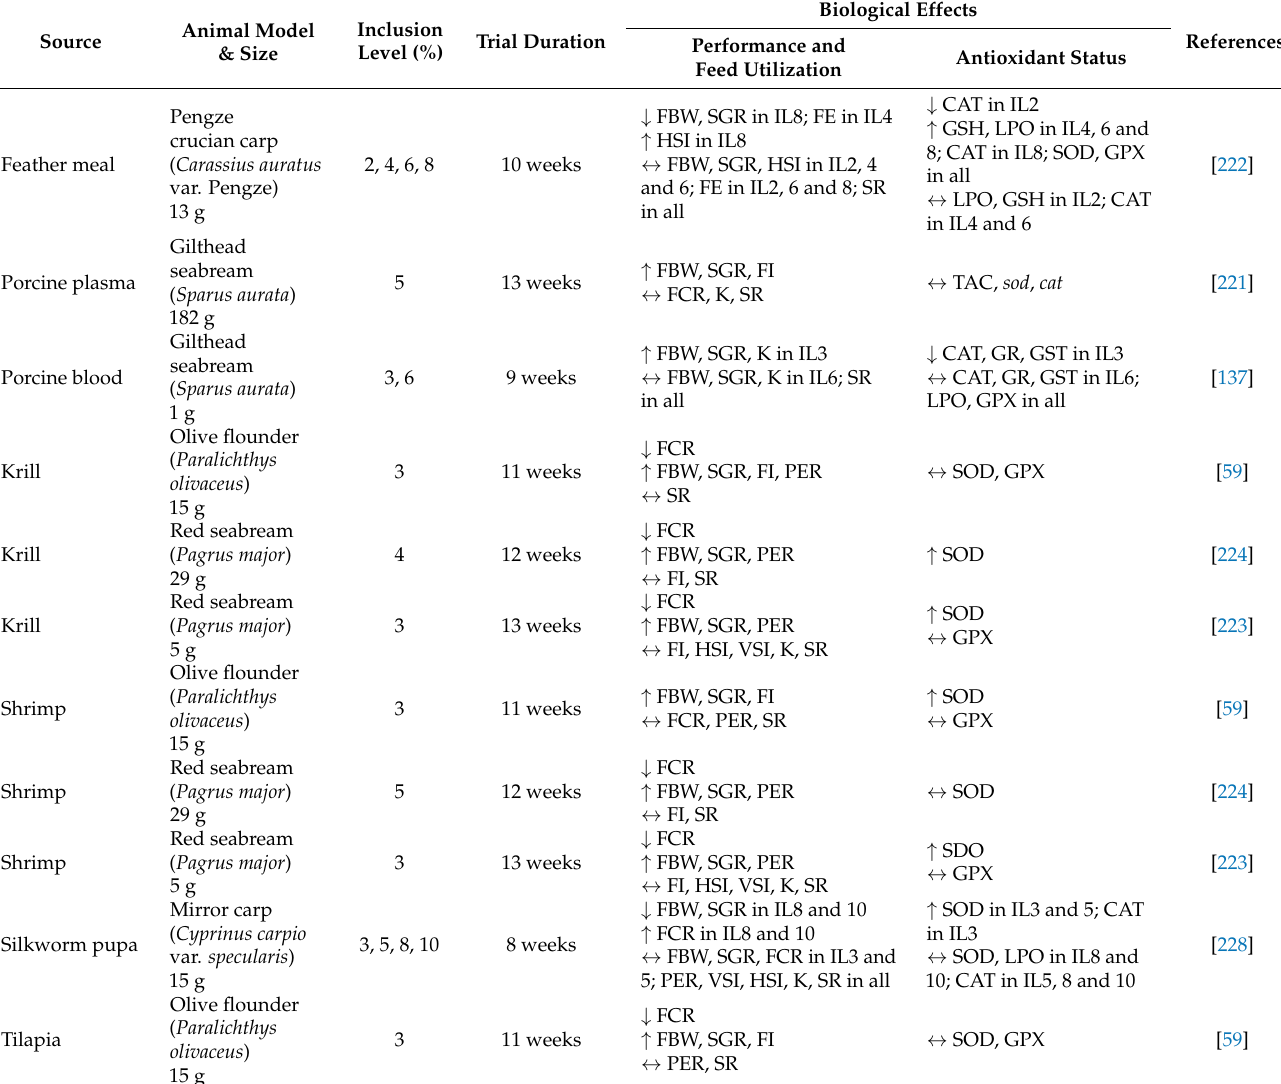
Table 5. Summary of new sources of dietary hydrolysates and their impacts on fish performance, feed utilization indicators, and oxidative stress